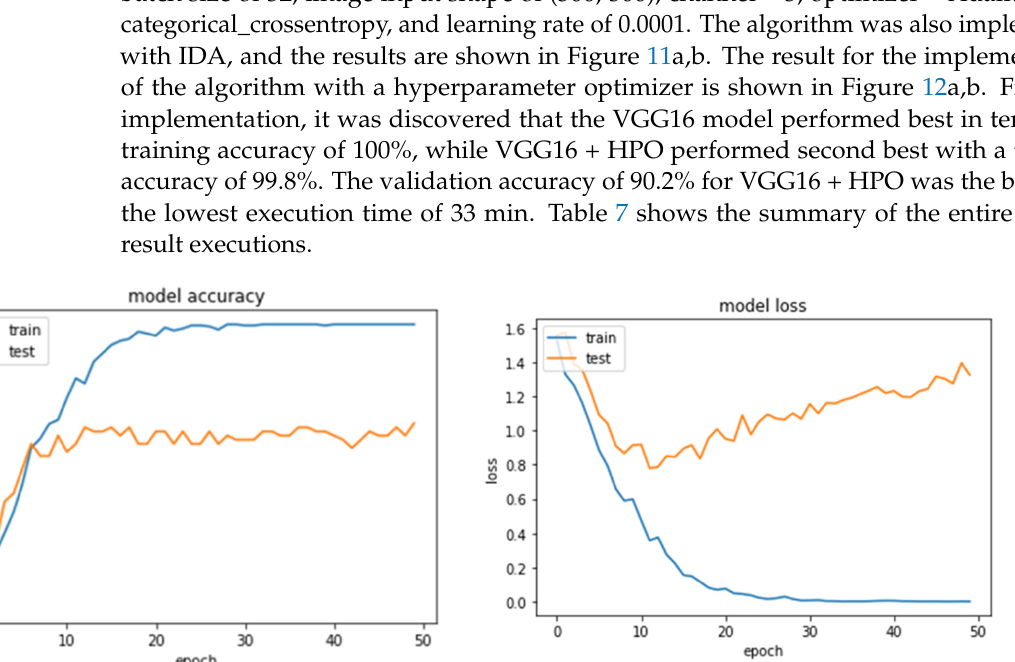
Table 7. Summary of VGG16 transfer learning results.